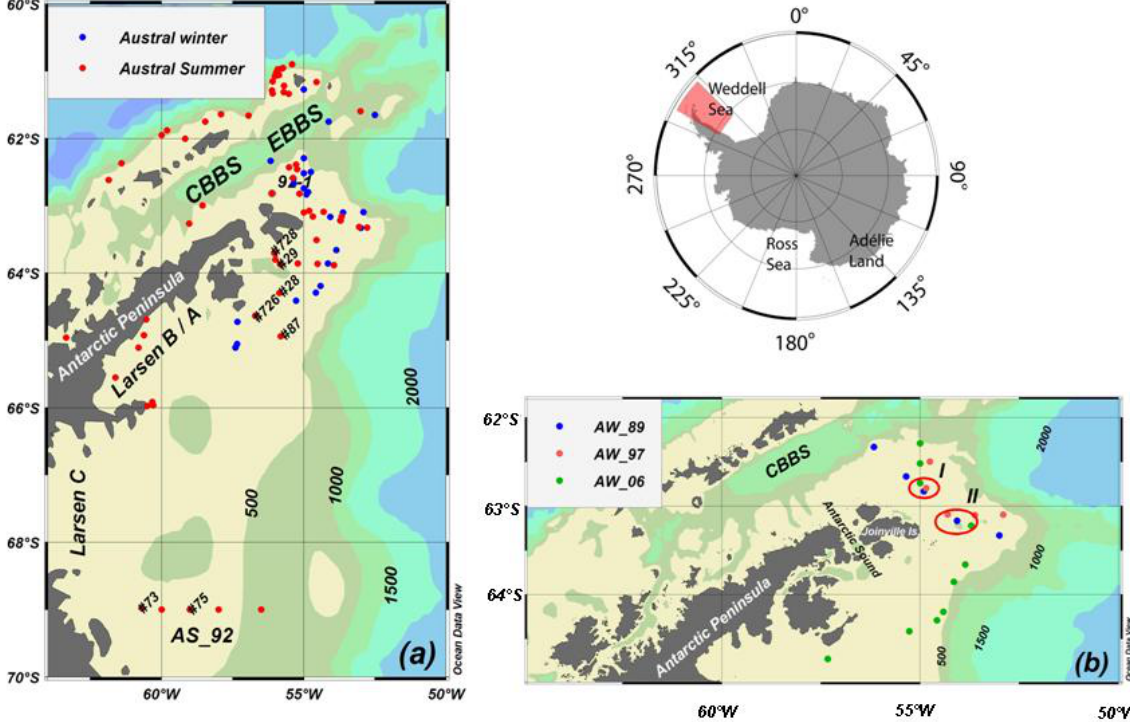
Fig. 1. Maps zoomed into the northwestern Weddell Sea (see inset) for (a) station distribution of austral winter (blue) cruises AW 89, AW 97, and AW 06, the Winter Weddell Sea Outflow Study (WWOS), together with austral summer (red) cruises AS 92, AS 06, and AS 09 (ATOS2) to the shallow ( < 500m) western Weddell Sea continental shelf (see Table 1 for cruise details). Numbers refer to stations used in Fig. 6 (AS 09-28, AS 09-29, AS 09-87, AS 06-726, AS 06-728), Fig. 8 (AS 92-75), and in the text (AS 92-73). Additional zoom for (b) shallow-shelf station distribution of the three winter cruises – see insert for color/cruise relation. Ellipse (I and II) encircles the stations providing the data for the θ /S diagrams (Fig. 3) and the profiles (Fig. 8). Depth contours are labeled and color-coded identically. CBBS = Central Basin of the Bransfield Strait, EBBS = Eastern Basin of the Bransfield